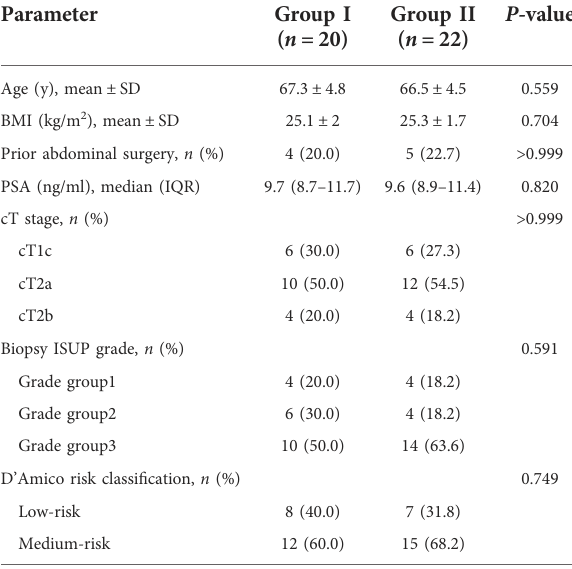
TABLE 1 Preoperative patient